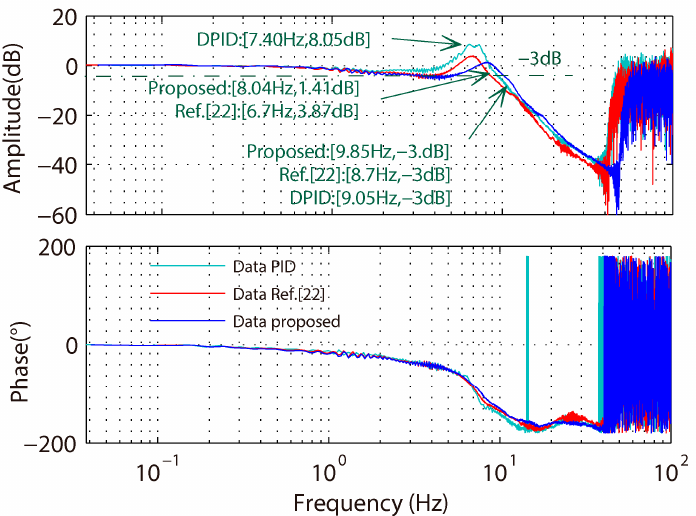
Figure 15. Contrast curve of the frequency characteristics of the control system.